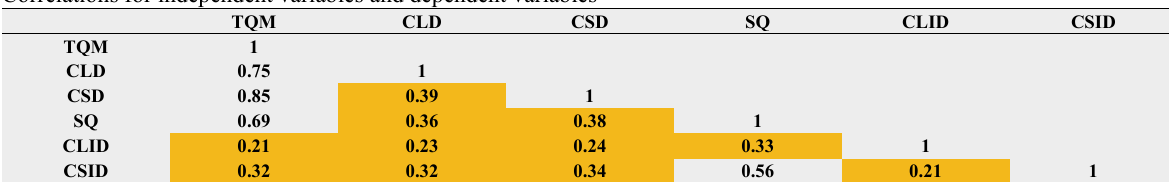
Fig. 5. Personal characteristics of the participants Correlations for independent variables and dependent variables